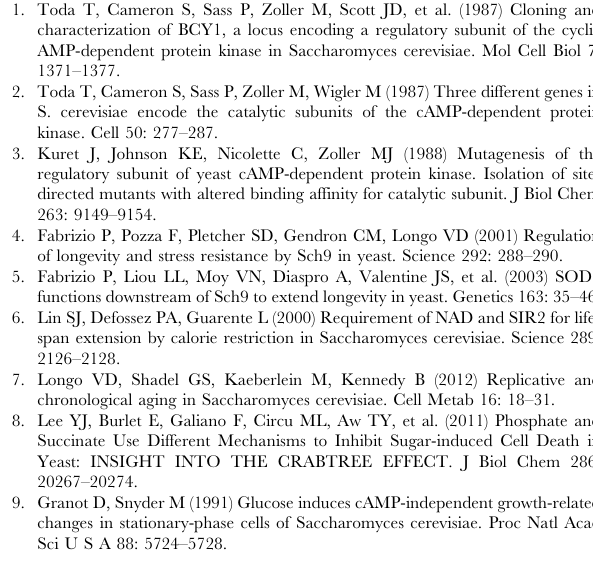
Table S1 The effects of triclabendazole and related compounds on growth and life span. Several structural analogs of triclabendazole were evaluated for their effects on growth (doubling time) and survival (t 1/2 ) in the chronological life span assay. Table S2 The effects of triclabendazole and its metab- olites on growth and life span. Triclabendazole, the triclabendazole sulfoxide (-SO), and the triclabendazole sulfone (-SO 2 ) were evaluated for their effects on growth (doubling time) and survival (t 1/2 ) in the chronological life span assay. Text S1 Materials and methods for the determination of the spontaneous mutation rates of yeast cells as a function of added